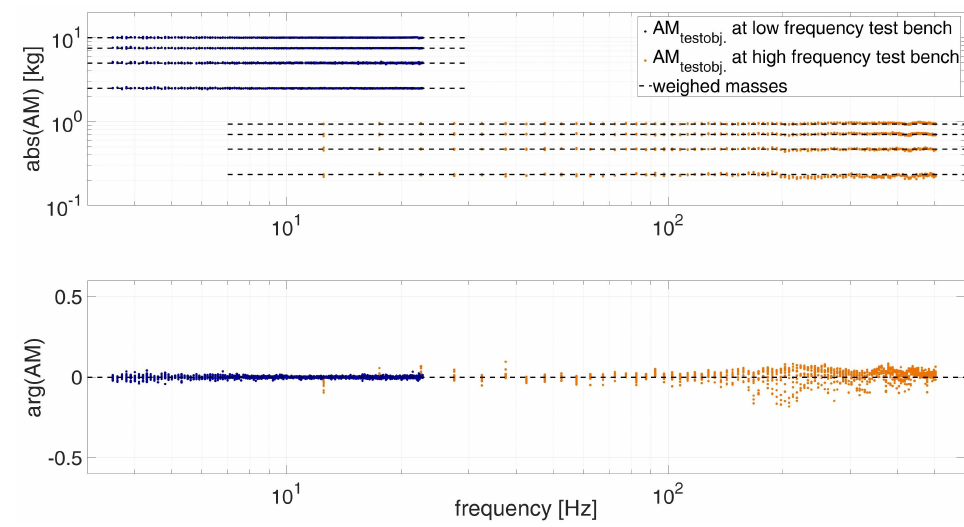
Figure 8. Calibrated apparent mass AM testobj . of freely vibrating masses over